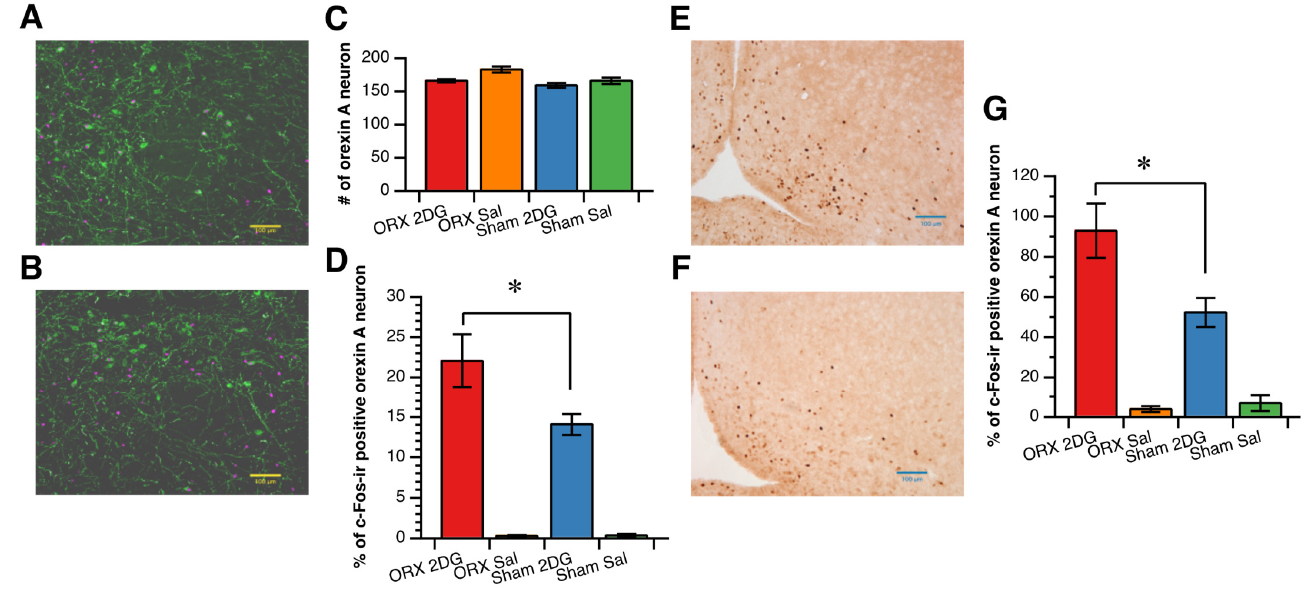
Figure 3. Effect of orchiectomy on the activation of orexin A neurons ( A – D ) and the activation of neurons in the arcuate nucleus ( E – G ) induced by 2-deoxy-D-glucose (2DG) administration. ( A , B ): Representative microscope images of c-Fos-immunoreactive (ir) nuclei (magenta) and orexin A immunoreactivity (green) in the lateral hypothalamic/perifornical area in the orchiectomized (ORX) group ( A ) and in the sham-operated (Sham) group ( B ). Scale bar = 100 µm. ( C ): Number of orexin A neurons in the lateral hypothalamic/perifornical area (917 × 662 µm). ( D ): Percentage of c-Fos-ir-positive orexin A neurons. ( D , E ): Representative microscope images of c-Fos-immunoreactive (ir) nuclei (dark brown) in the arcuate nucleus in the orchiectomized (ORX) group ( E ) and in the sham-operated (Sham) group ( F ). Scale bar = 100 µm. ( G ): Number of c-Fos-ir neurons in the arcuate nucleus. Data are shown as the mean and SE in C and D ( n = 7 in the ORX_2DG group; n = 6 in the Sham_2DG; n = 4 in the ORX_Sal; and n = 4 in the Sham_Sal group). *: significant difference between the ORX_2DG group and the Sham_2DG group at p < 0.05.